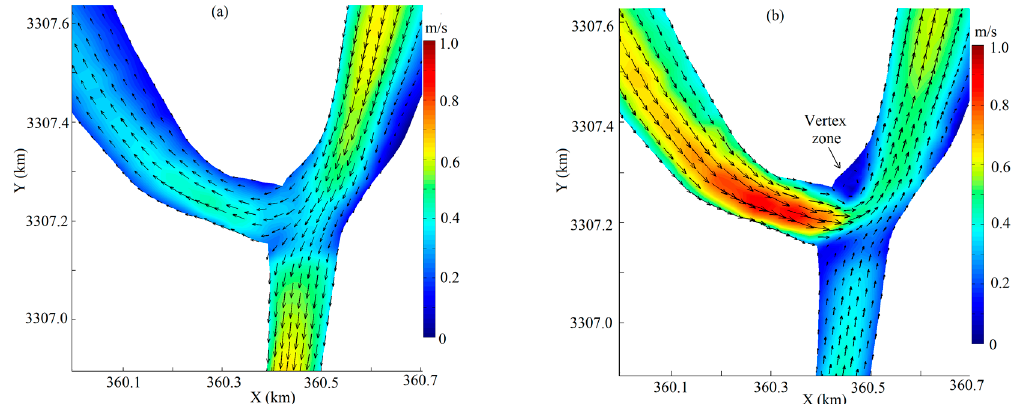
Figure 15. Tidal flow fields during the second half of June 2015: ( a ) At the maximum flood tide; ( b ) At the maximum ebb tide.